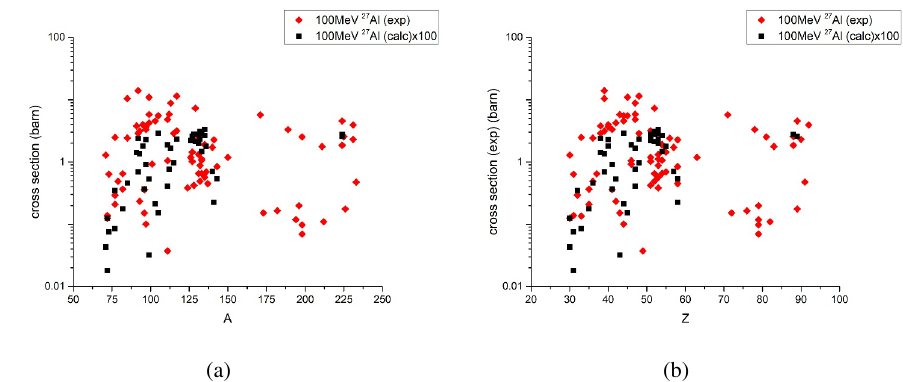
Figure 5: Graph of the cross sections for aluminum irradiated by 100 MeV